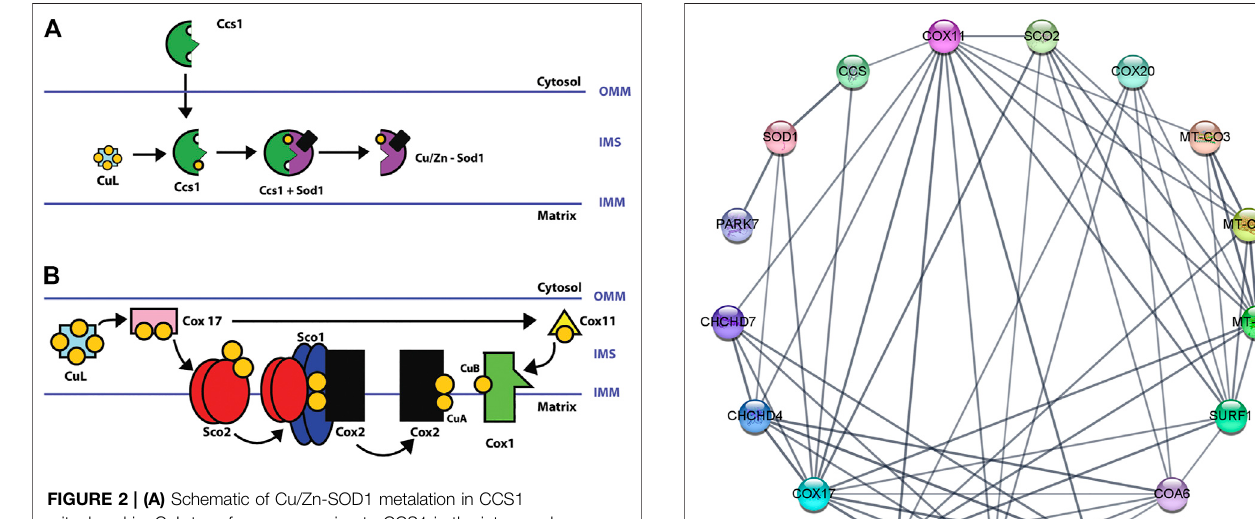
FIGURE 2 | (A) Schematic of Cu/Zn-SOD1 metalation in CCS1 mitochondria. CuL transfers a copper ion to CCS1 in the intermembrane space. The incorporation of zinc may be during or before metalation with copper by CCS1. SOD1 is metalated in the intermembrane space (IMS) ofmitochondriaandthenentersthematrix(Cobineetal.,2006a;Cobineetal., 2006b; Robinson and Winge 2010; Fukai and Ushio-Fukai 2011). (B) Metalation of COX copper centers (CuA and CuB sites). COX is assembled in partsthatarethenmergedtoproducethematuredholoenzymecomplex.The COX1 subunit contains the CuB site, and the COX2 subunit, the CuA site. After entering mitochondria, CuL donates two copper ions to the copper chaperone COX17 which in turn transfers the copper ions to COX11 and SCO2. COX11 metalates the CuB site of the subunit COX1, and SCO2, the CuA site of subunit COX2 by delivering two copper ions in a SCO1-mediated process (Robinson and Winge 2010; Jett and Leary 2018).